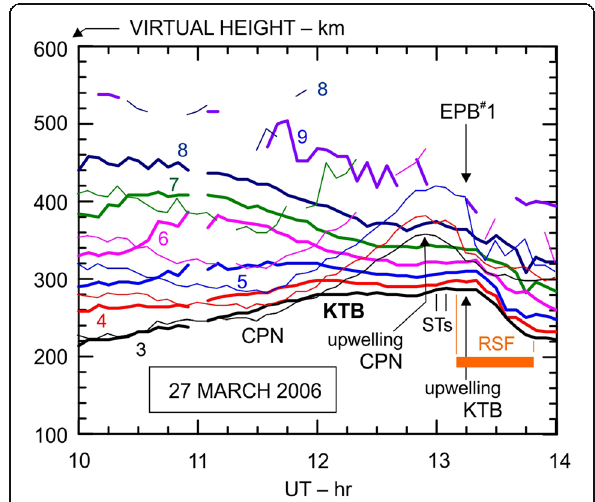
Fig. 12 A composite plot of h ’ f curves (at integer plasma frequencies) for KTB (bold lines) and CPN (thin lines) for 27 March 2006. First upward arrow marks the time when upwelling was seen over CPN. Second arrow (20 min later) marks the time when EPB was observed with EAR and when a mild upwelling was observed over